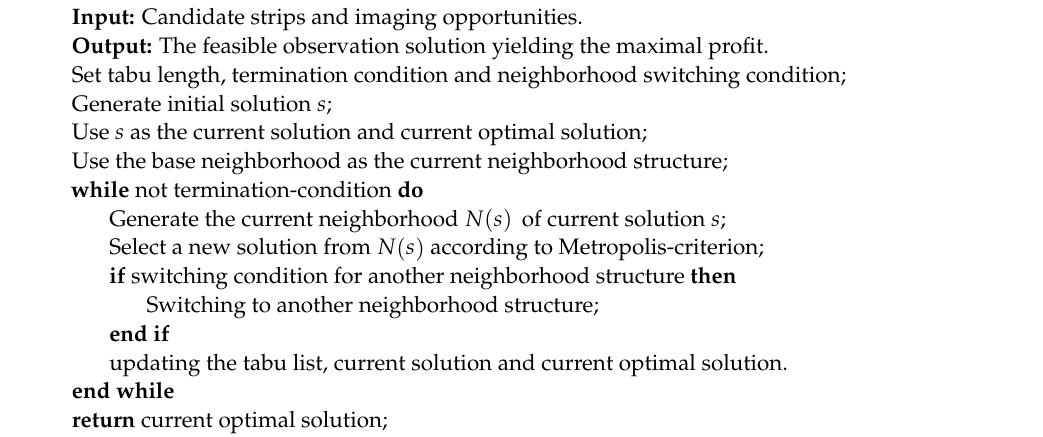
Algorithm 2 Steps of variable neighborhood tabu search